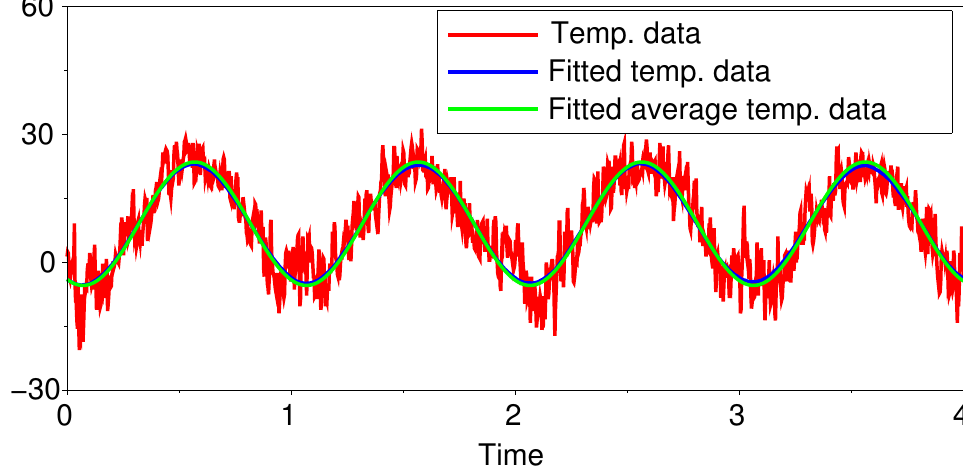
Figure 5. Plot of the observed temperature data { T j : j = 1,2, . . . ,1461 } , the fitted temperature data { ˆ T j : j = 1,2, . . . ,1461 } and { E ( ˆ T j ) : j = 1,2, . . . ,1461 } from